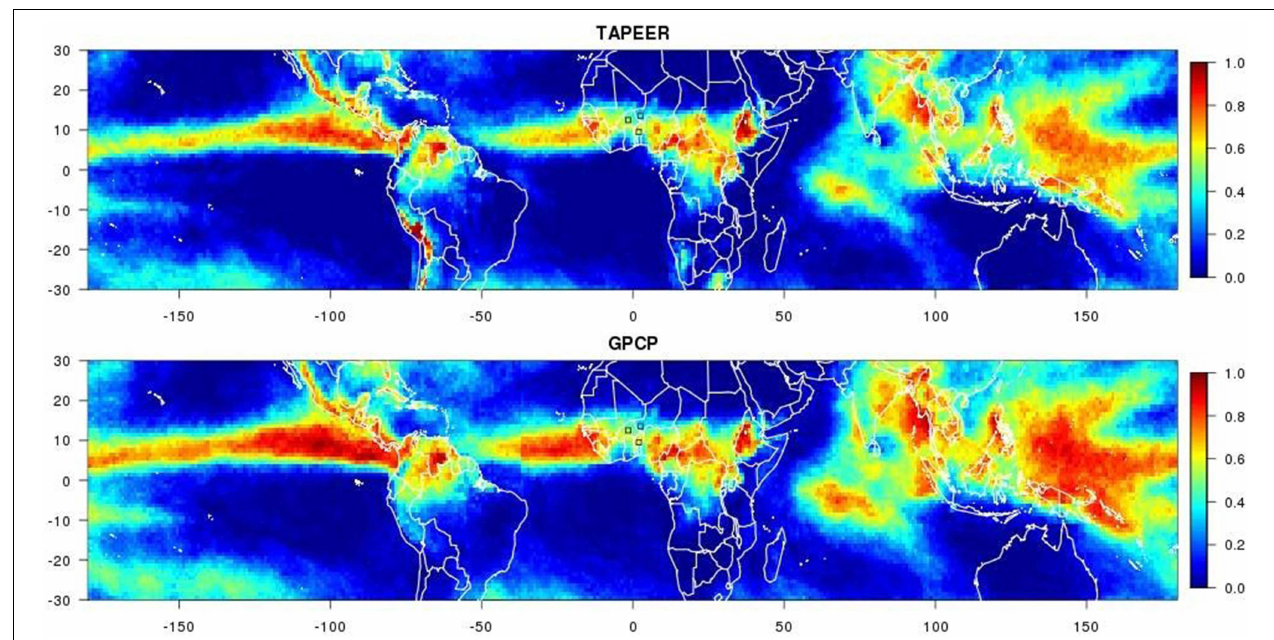
FIGURE 8 | Fraction of the time with rainy days above 1mm/day in the JJAS 2012 period, as seen by TAPEER (top) and GPCP (bottom).